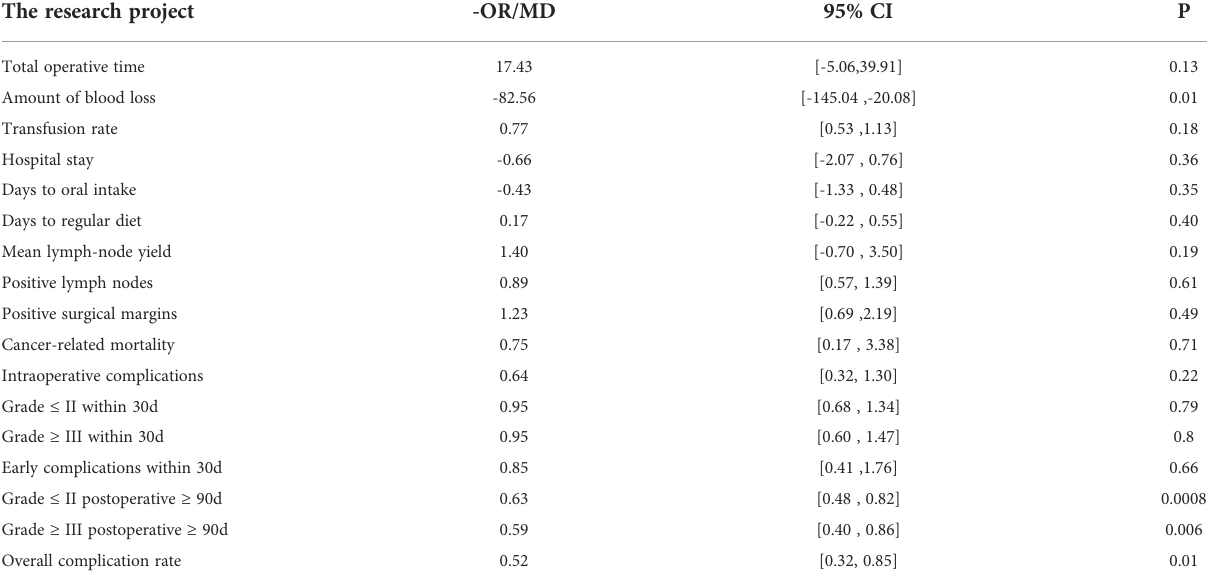
TABLE 3 Summary of research results.